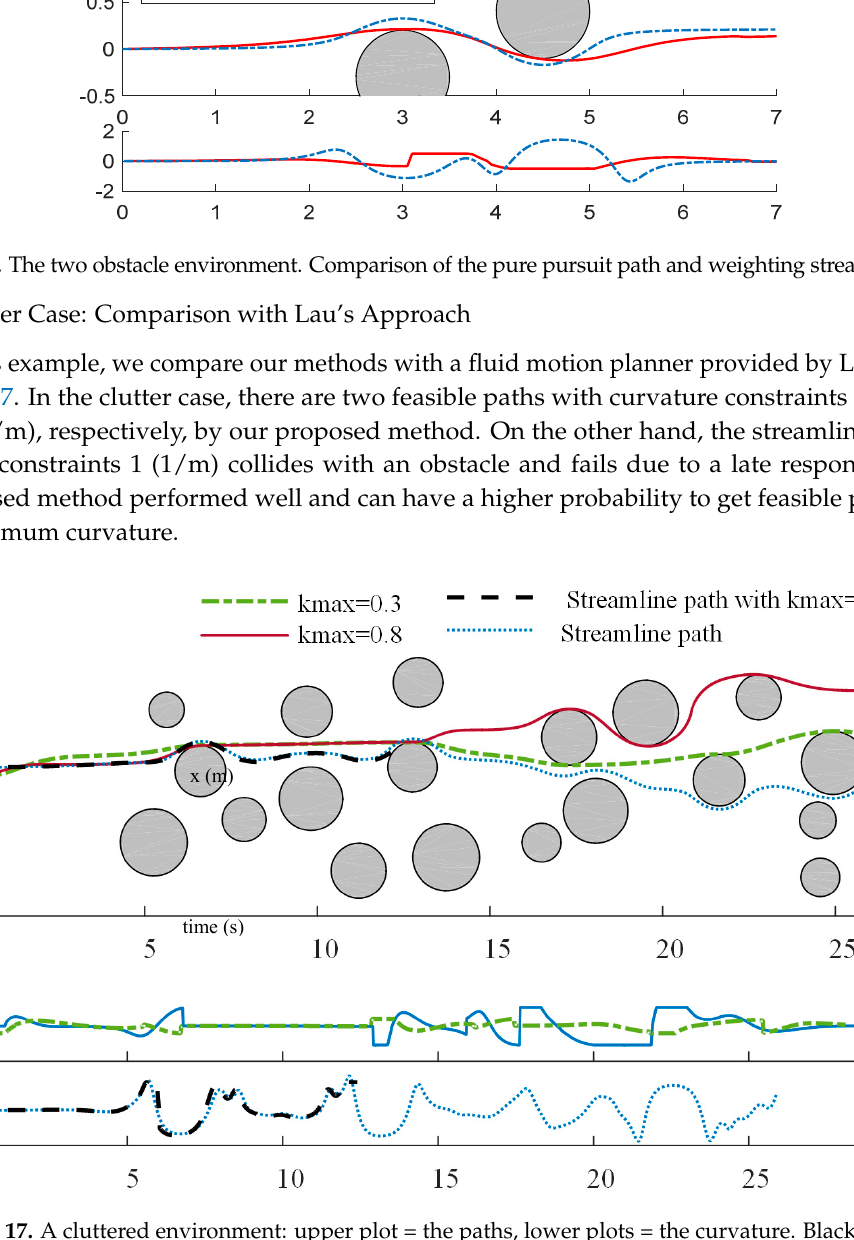
Figure 17. A cluttered environment: upper plot = the paths, lower plots = the curvature. Black dashed path denotes the path generated by the method of superposition that collides with the obstacle.